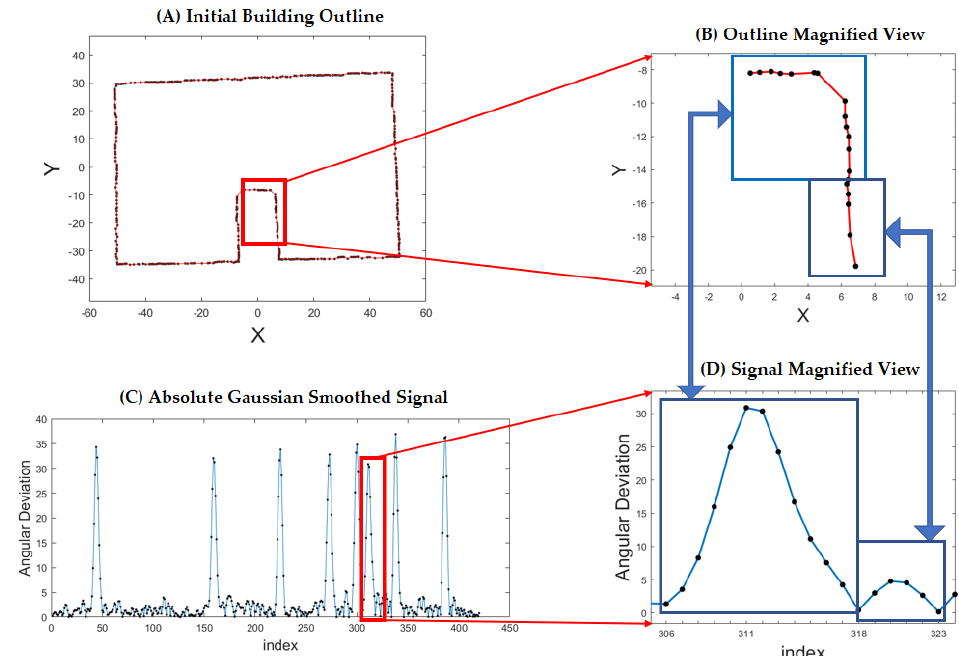
Figure 9. Subdivide the denoised signal and calculate features. ( A ) The initial building outline; ( B ) the portion of the initial building outline from vertex number 306 to 327; ( C ) the denoised signal (absolute value); ( D ) the magnified view of the denoised signal from 306 to 327.